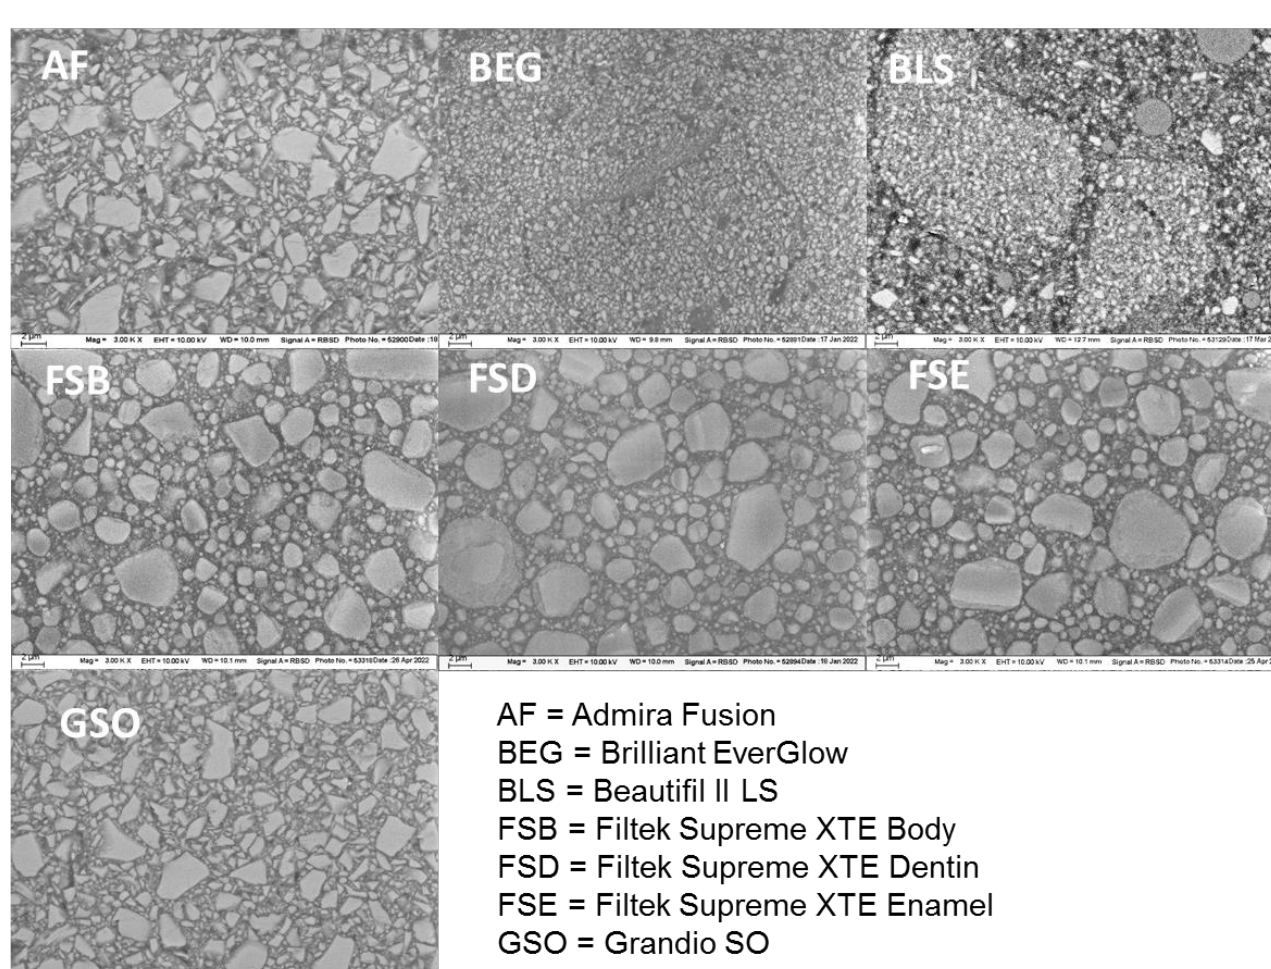
Figure 6. SEM images: structural appearance of the filler systems, as measured using the electron backscatter diffraction mode. Material abbreviation: AF = Admira Fusion; BEG = Brilliant EverGlow; BLS = Beautifil II LS; FSB = Filtek Supreme XTE Body; FSD = Filtek Supreme XTE Dentin; FSE = Filtek Supreme XTE Enamel; GSO = Grandio SO.